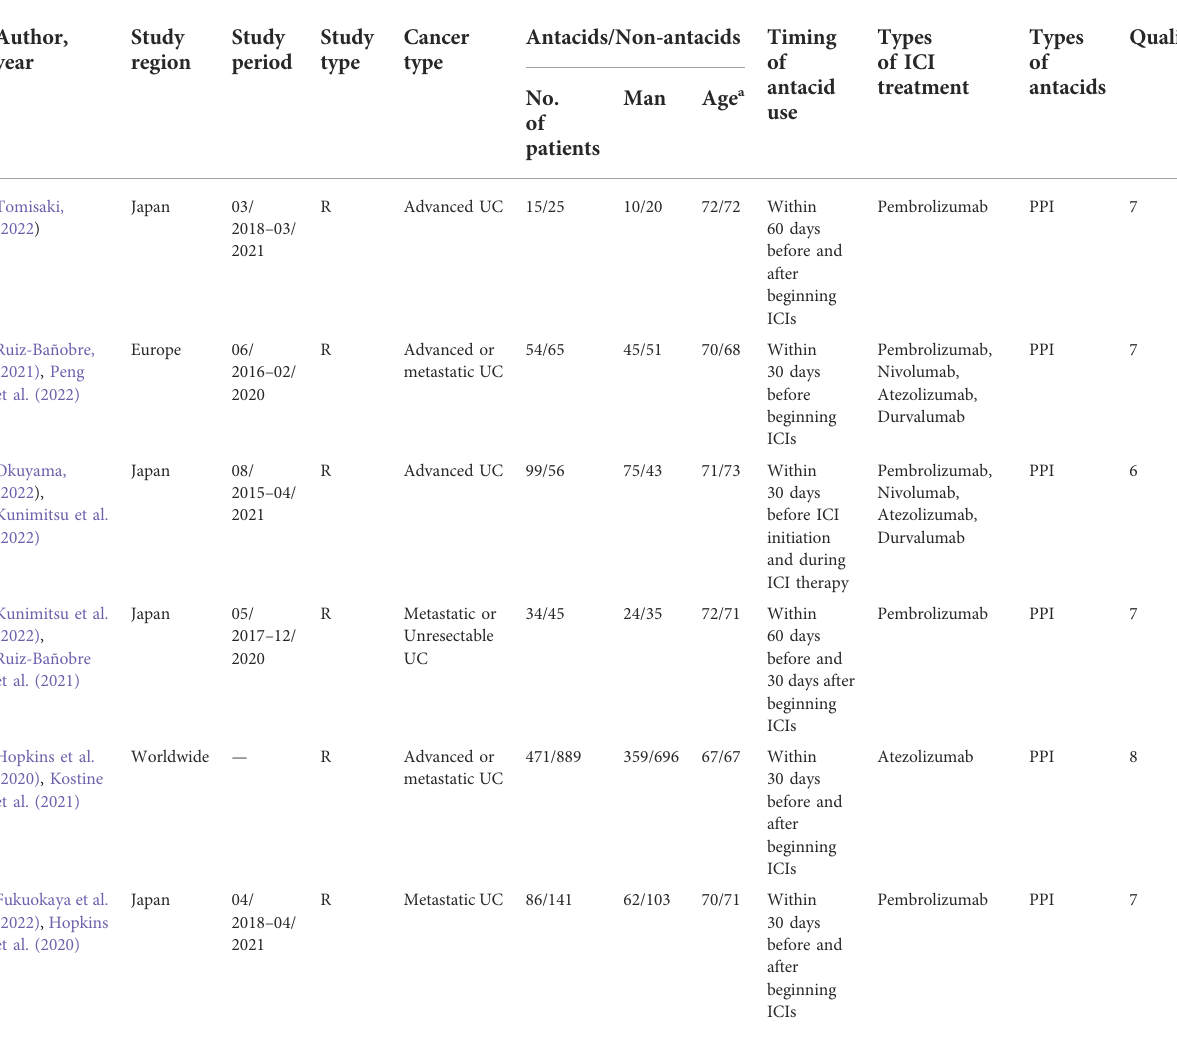
TABLE 1 Baseline characteristics of included